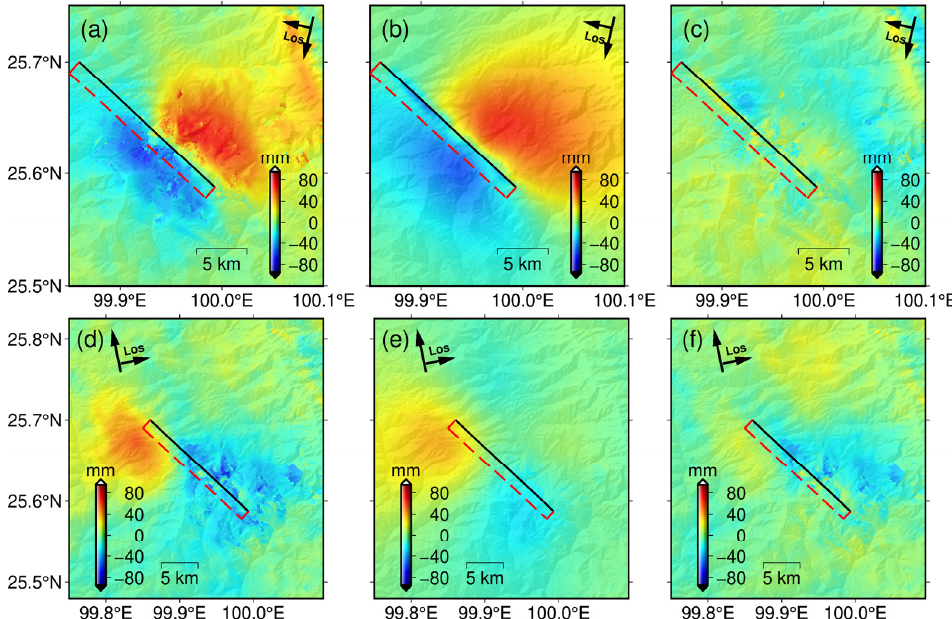
Figure 7. Inversion results of the distribution slip inversion model for the Yangbi earthquake; ( a , d ) are the observed coseismic interferograms of the descending and ascending tracks, respectively; ( b , e ) are corresponding modeled data; ( c , f ) are the residuals. In ( a – f ), the thick black line depicts the fault surface trace of the distributed slip model, while the dashed red line shows the surface projection of the rupture fault plane.